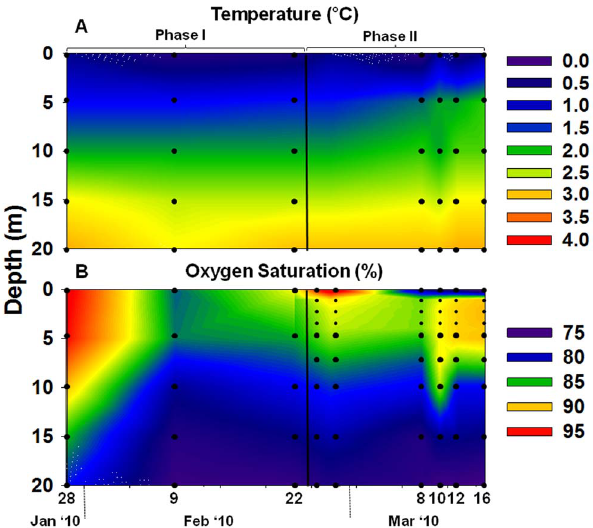
Figure 1. Temperature (A), and oxygen saturation (B) profiles during Phase I and Phase II of the bloom. Black circles represent sampling points. Data are available at a higher spatial resolution only during Phase II of the bloom (small black circles).